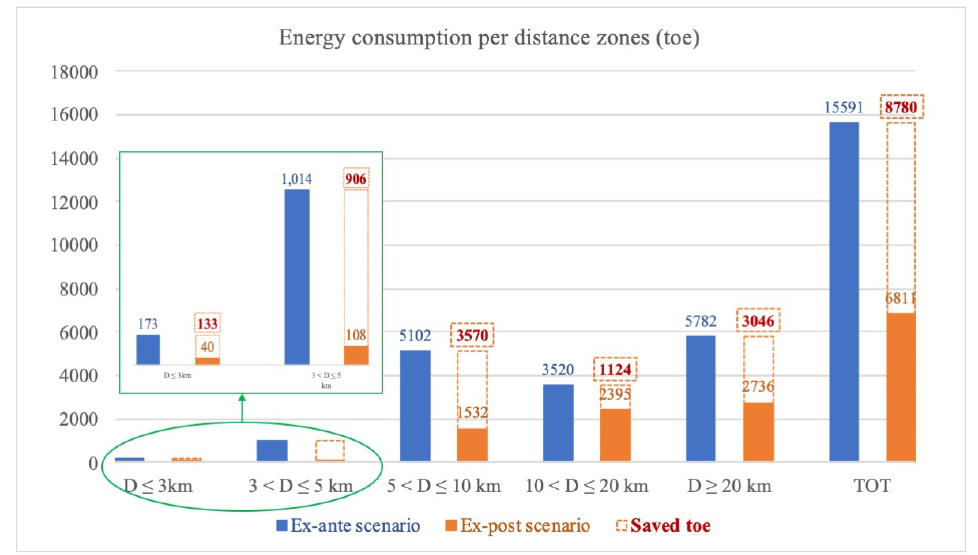
Figure 7. Yearly fossil fuels energy amounts (toe) involved in the actual ex-ante (0) and improved ex-post (1) scenarios.